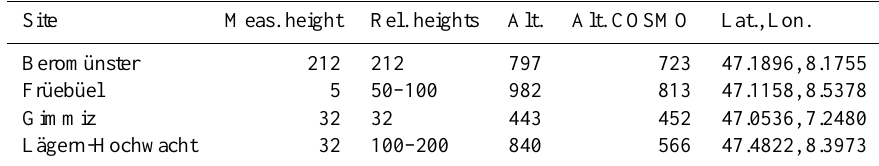
Table 2. Simulation characteristics for the four measurement sites of the CarboCount CH network. Listed from left to right are the FLEXPART-COSMO particle release heights (above model ground level), the “true” site altitudes (ma.s.l.), smoothed COSMO numeri- cal weather prediction model’s ( ∼ 4km 2 ) site altitude, and the geographic site